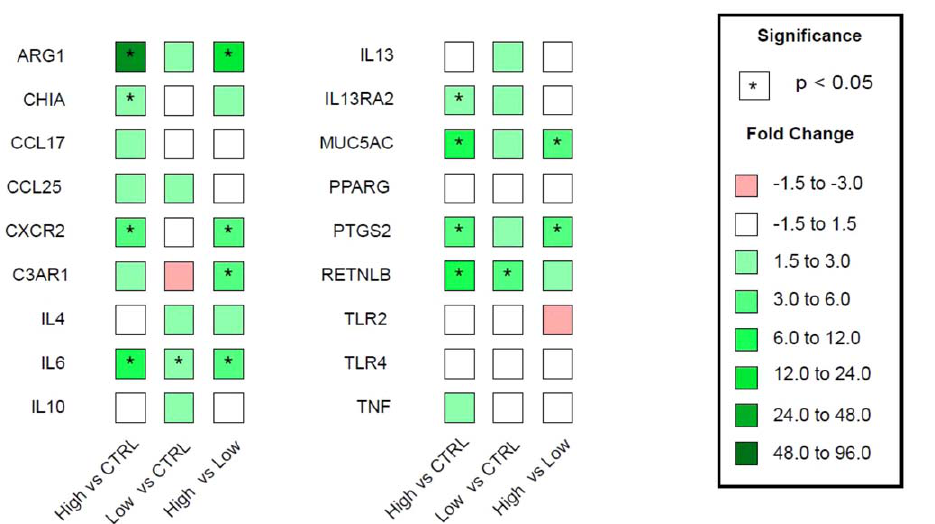
Figure 1. Localized changes in gene expression in the proximal colon epithelium. The relative changes in gene expression were determined by real-time RT-PCR (TaqMan) and compared between T. suis -infected pigs with a high worm burden (High) and low worm burden (worm-free or Low), and uninfected naı¨ve control pigs (CTRL).